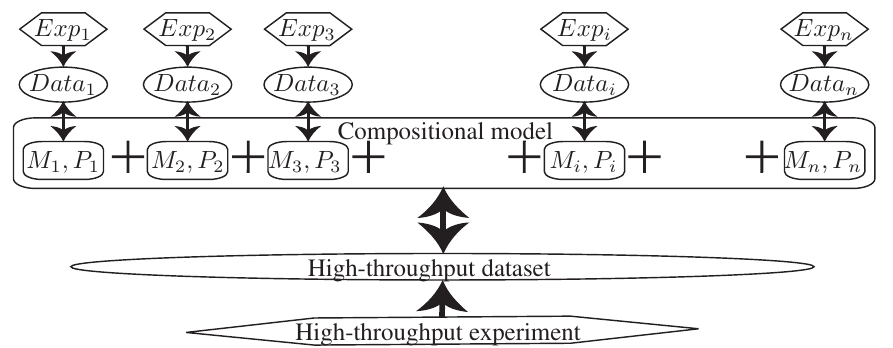
Figure 1: Relation between local models and data and between systemic model and high- throughput data. Each local model M x with the corresponding parameters P x can be tuned and validated with data ( Data x ) produced by specific experiments ( Exp x ). The systems biology model, built composing the local sub-models, have new possibilities of integration with high-throughput data. The + symbol stands for the abstract compositional operator of the